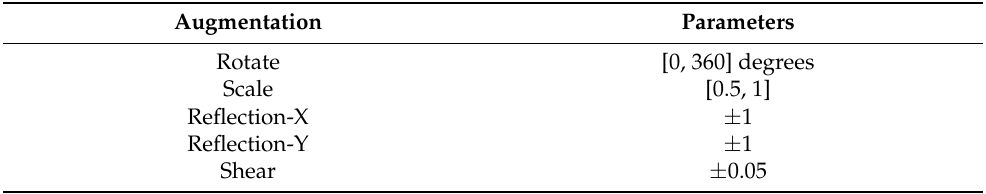
Table 1. Dataset augmentation details.